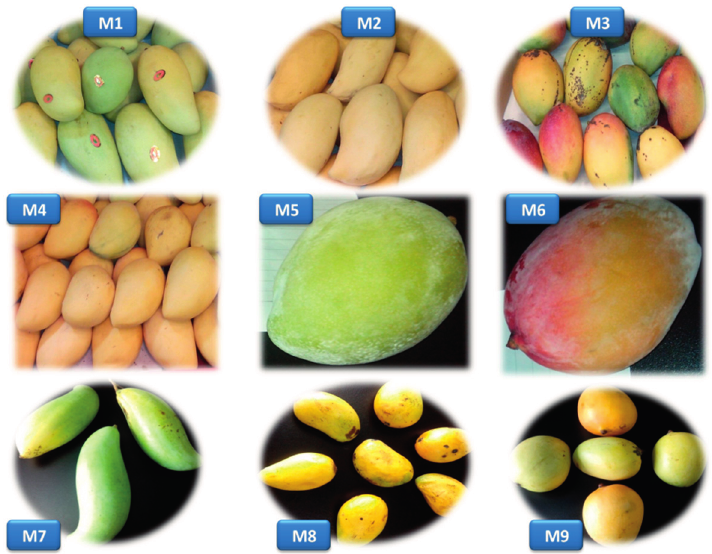
Figure 4. Mango cultivars used in the present analysis. M1, Luzon mango